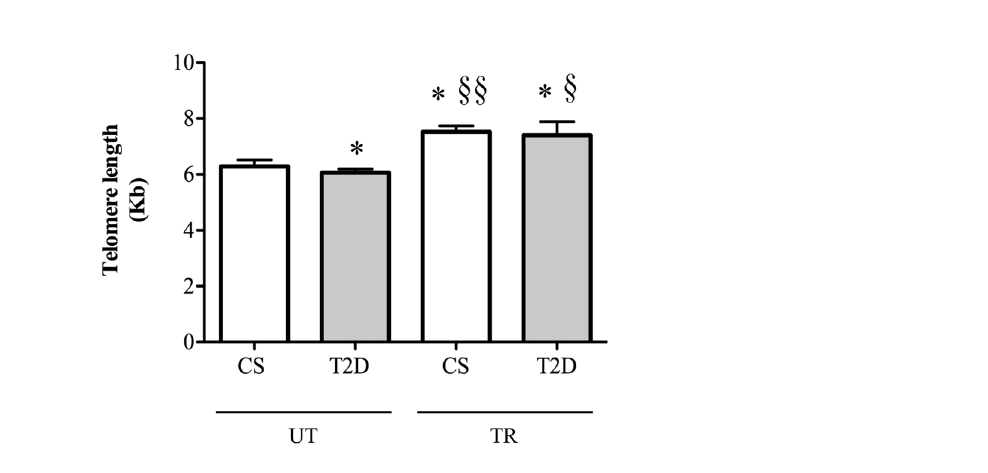
Figure 1. Comparison of leukocytes telomere length in study participants: control subjects (CS) and diabetic patients (T2D) when untrained (UT) and trained (TR) respectively. * p < 0.05 vs . UT-CS, §§ p < 0.01 vs . UT-T2D, § p < 0.05 vs .